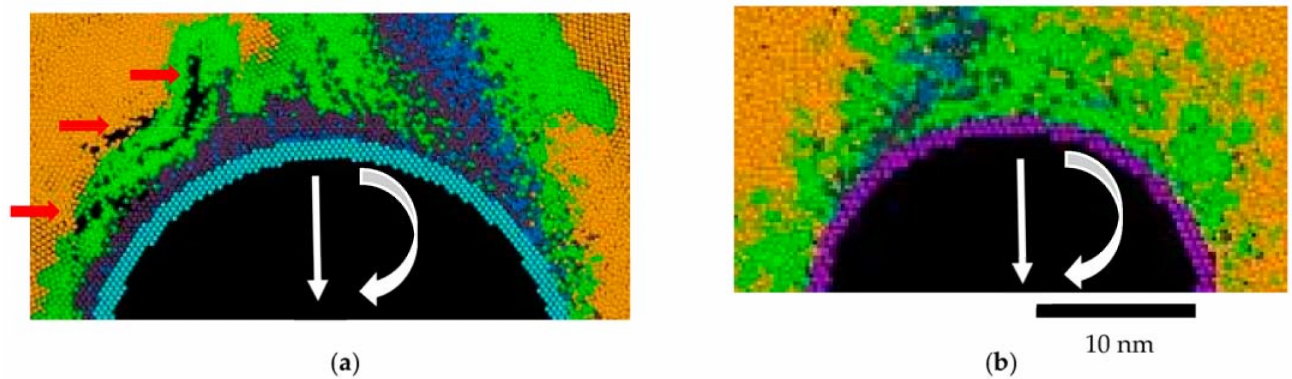
Figure 1. Atomic configurations after welding at 0.01 (ps − 1 )/100 (m/s) for a pin radius of ( a ) 12 nm (normalized weld pitch of 8.3 × 10 0 and Tmax of 744 K) and ( b ) (normalized weld pitch of 2.0 × 10 1 and Tmax of 935 K) ( b ) 5 nm. The colors indicate the initial location of the atoms except black, which represents air. Red arrows indicate the location of defects (pores). White arrows indicate the advancing and rotating directions. The color of the atoms refers to their initial position prior to the weld except for the circle of material around the pin. The colors in their atoms’ initial positions are shown in Figure 2 with the following sequence: blue, violet, green, orange, and pink.